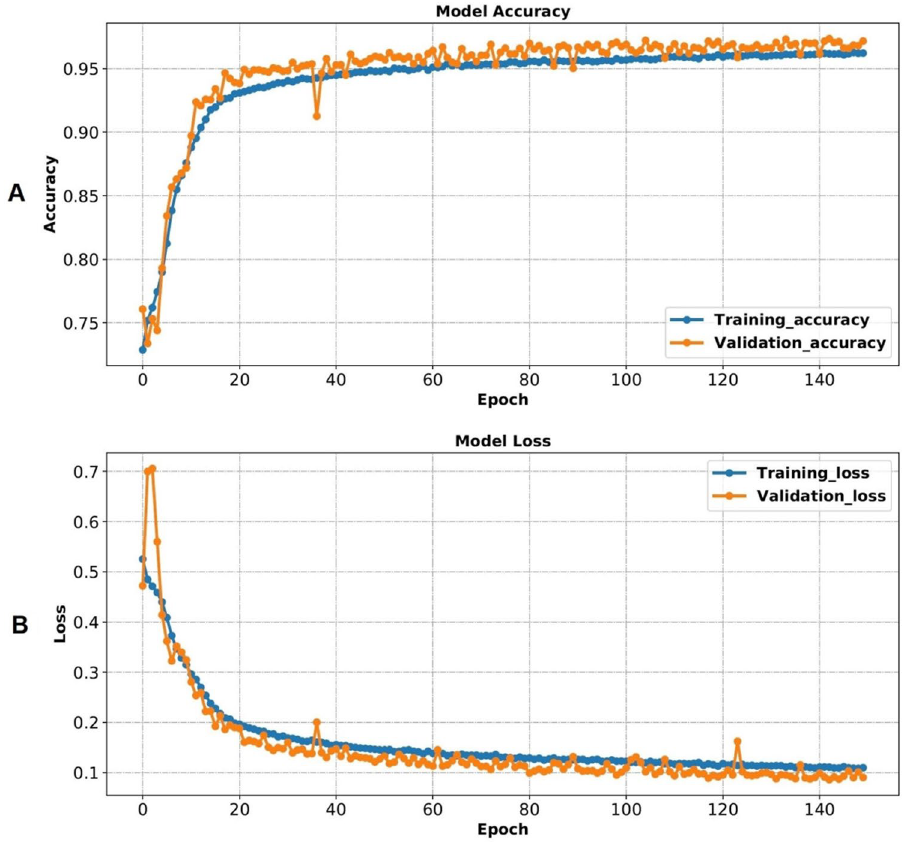
Figure 6. ( A ) The model accuracy during training and validation. ( B ) The model loss during training and validation.